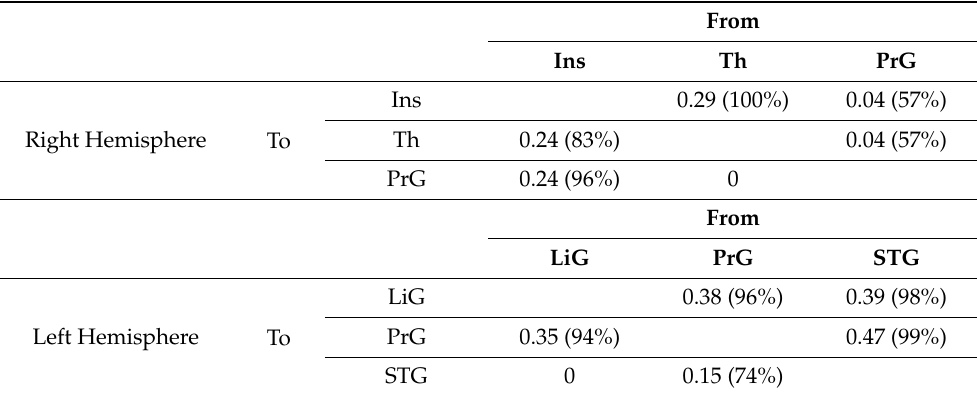
Table 1. Correlations of the three regions in each of the right and left hemispheres while performing a secondary task while driving.